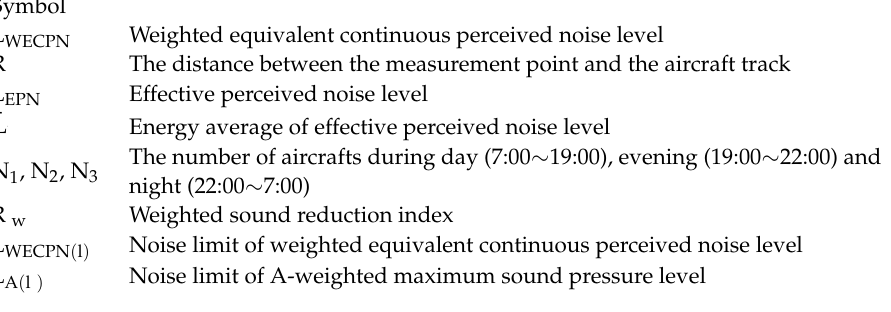
Figure 4. Noise reduction effects before and after using the low-noise aircraft type during summer: ( a ) area; ( b )